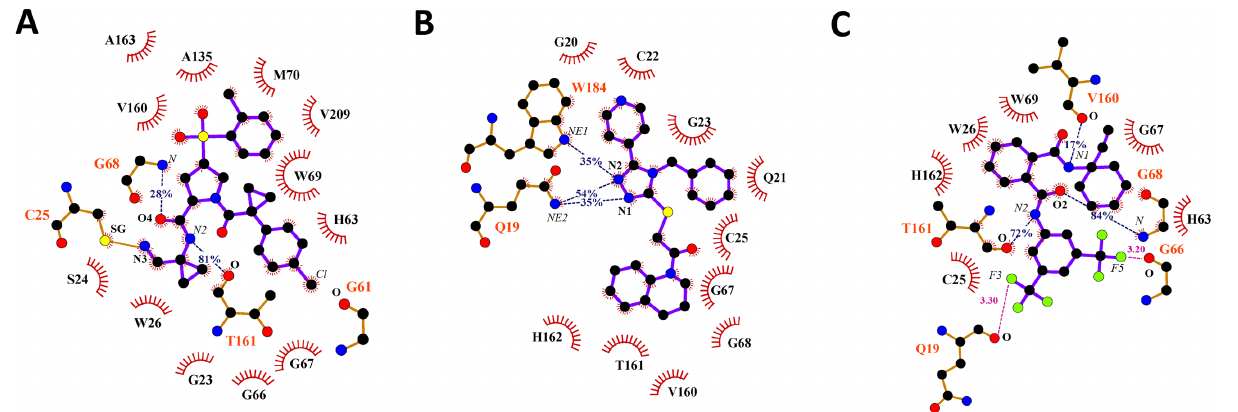
Fig 6. Diagrams of protein-ligand interactions. FhCL3 residues interacting with Nitrile (A), HTS12701 (B), BTB03219 (C). Ligands (violet) and protein residues involved in polar interactions (brown) are depicted in ball and stick representation. Hydrogen (blue dashed lines) and halogen (purple dashed lines) bonds are shown together with their occupancy percent and distance values, respectively. Hydrogen donor and acceptor labels are shown in italic and bold styles, respectively. Residues establishing non-polar contacts are depicted as red semicircles.